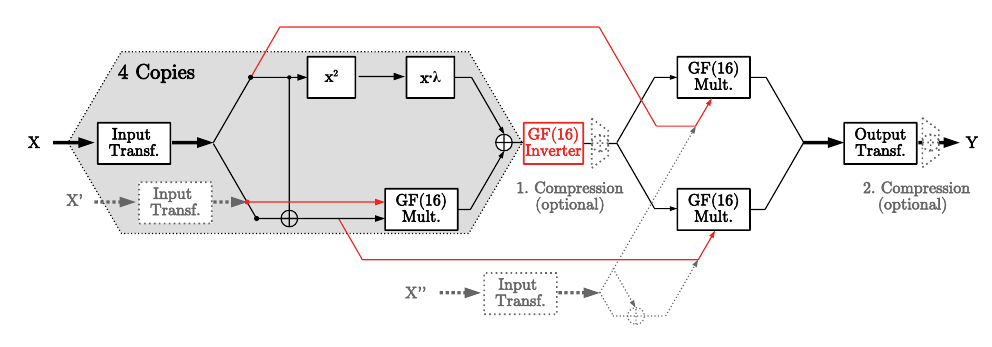
Figure 9: Mui S-box design (black and red parts are from the original design), gray dotted paths and elements replace the red paths to which they are connected in the collision-free